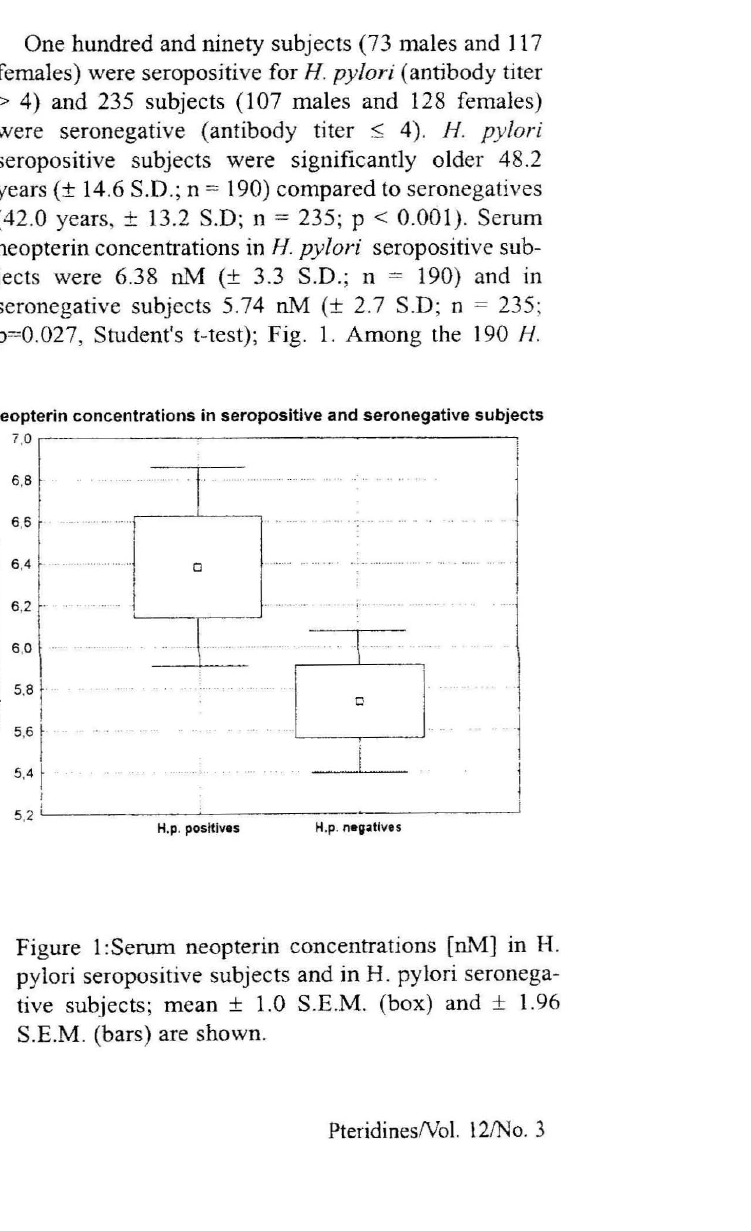
Figure I : Serum neopterin concentrations [nM) in H. pylori seropositive subjects and in H. pylori seronega tive subjects; mean ± l.0 S.E.M. (box) and ± 1.96 S.E.M. (bars) are